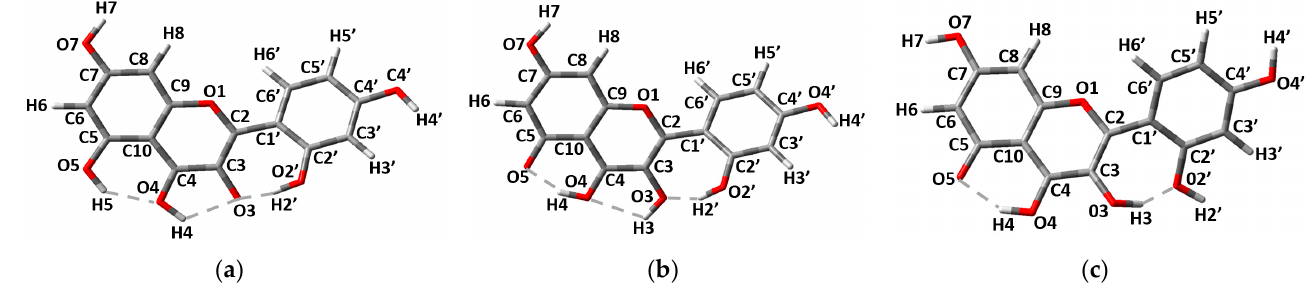
Figure 6. Keto forms of M : MCA in keto OH3 form ( a ), MCA in keto OH5 form ( b ), MCB in keto OH5 form ( c ). Table 1. Absorption and emission of MCA and MCB obtained at TDDFT-M06-2X/6-31++G(d,p) level of theory.